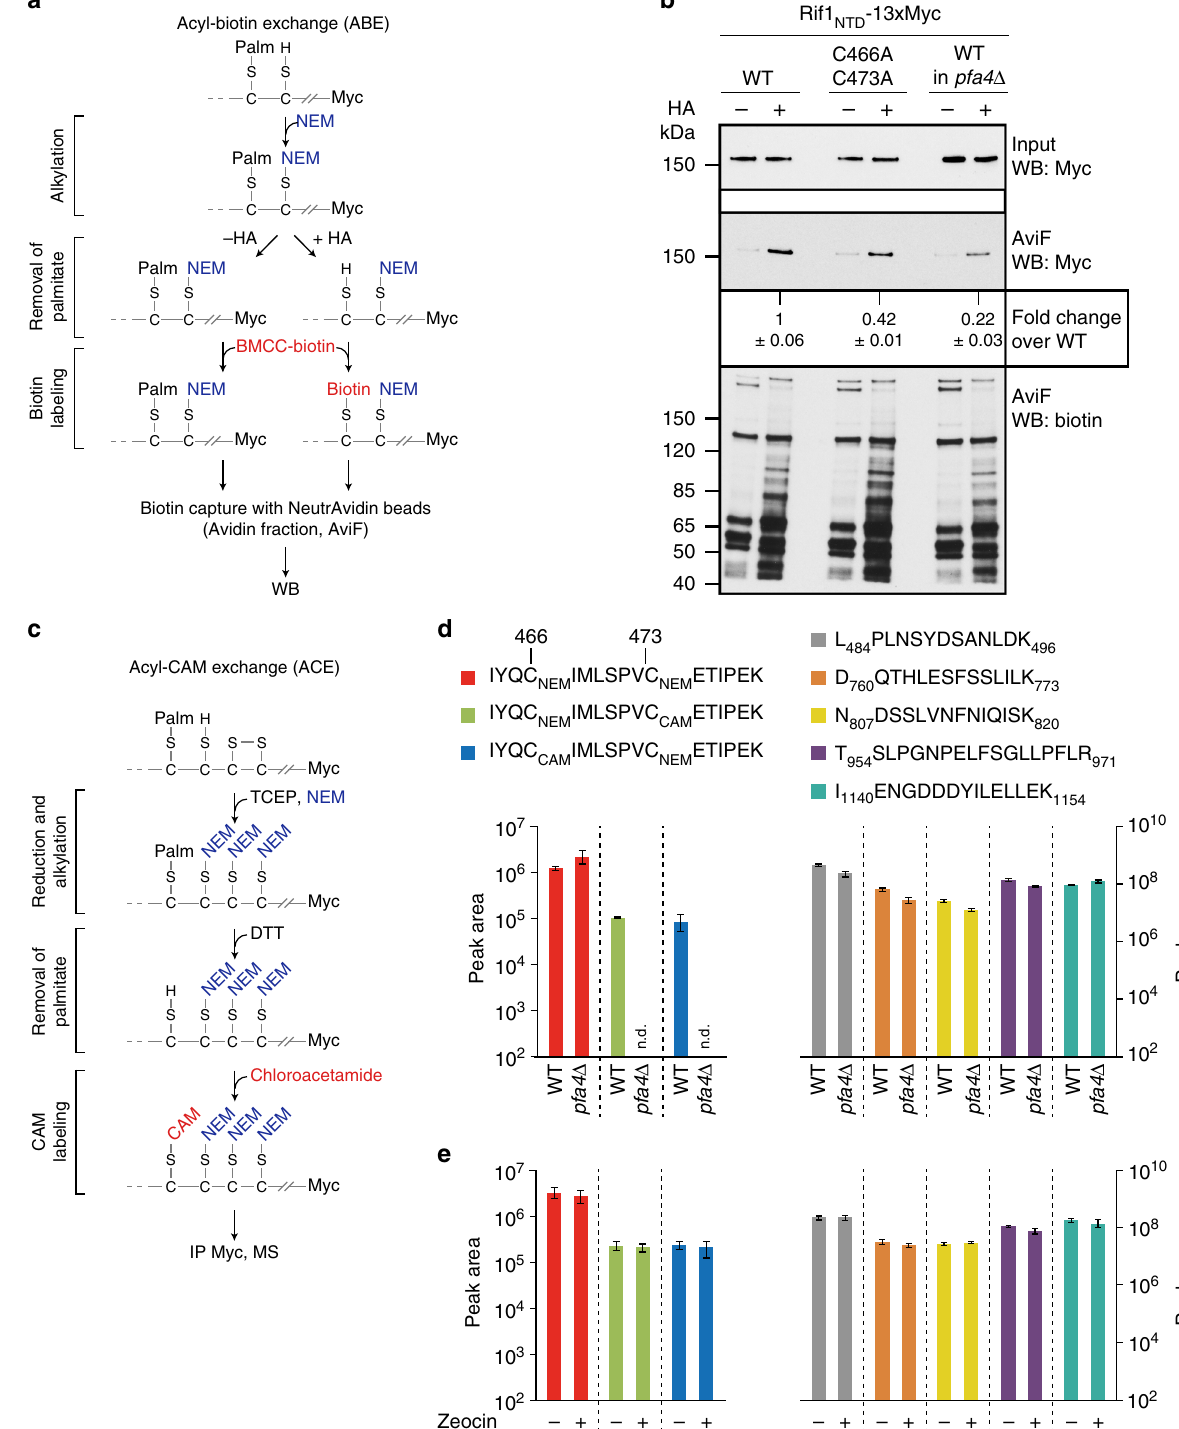
identi fi cation of S -palmitoylation sites in peptides with high sensitivity (see Supplementary Fig. 4b, c). Immuno-precipitated Rif1 NTD was subjected to parallel reaction monitoring (PRM), analyzing NEM and/or CAM-labeled C466 and C473 in tryptic peptide fragments spanning residues 463 to 479. Peptides containing NEM-labeled C466 and C473 were detected in wild- type and pfa4 Δ cells, accounting for unmodi fi ed Rif1 NTD . Tryptic fragments containing either CAM-labeled C466 or CAM-labeled C473 were detected in wild-type cells, providing site-speci fi c